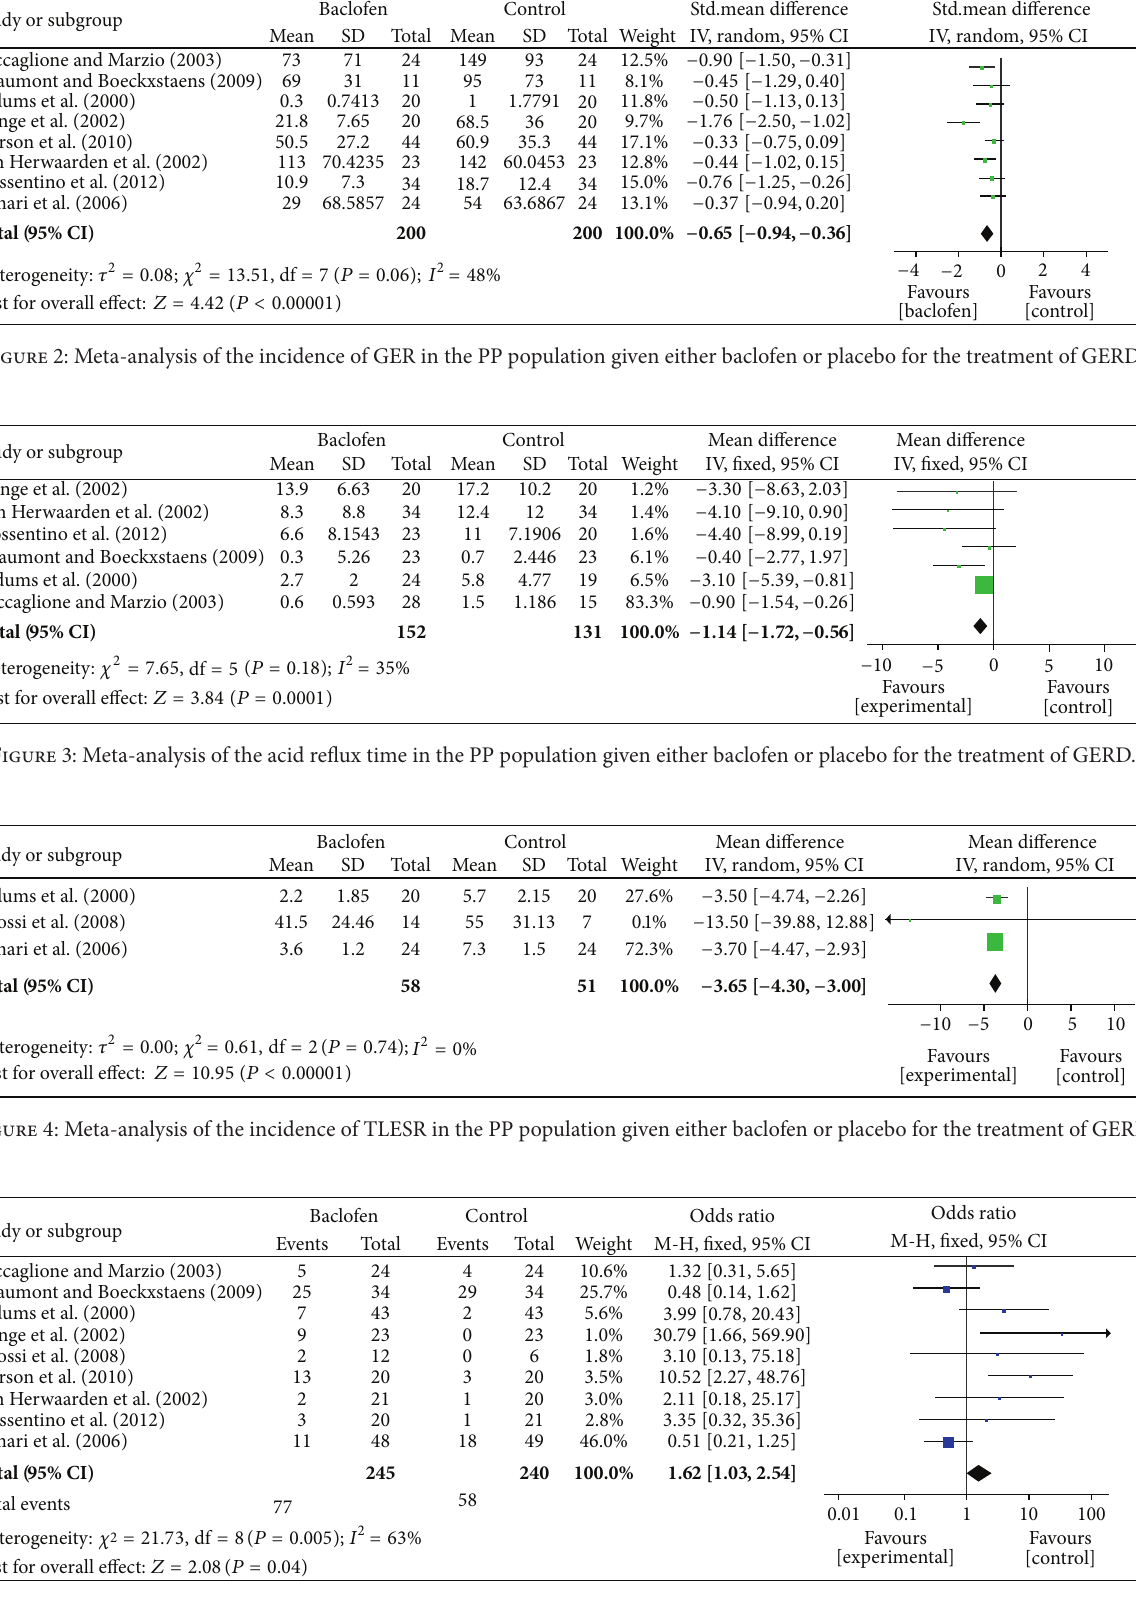
Figure 5: Meta-analysis of the overall adverse events in the PP population given either baclofen or placebo for the treatment of